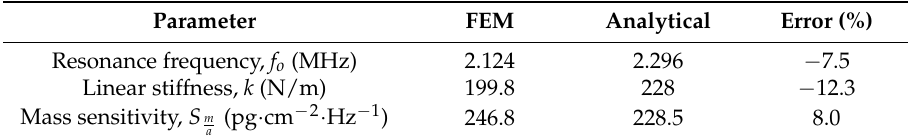
Table 1. Main resonator parameters comparison obtained from finite element modeling (FEM) simulations and using the approximated analytical solution. A mass density ρ = 3000 kg/m 3 and a Young’s modulus E = 131 GPa have been assumed for the complementary metal-oxide-semiconductor (CMOS) top metal layer to compute the parameters.